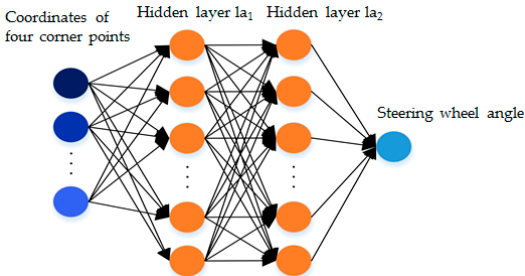
Figure 8. The structure of actor network and target actor network. Sensors 2019 , 19 , x FOR PEER REVIEW